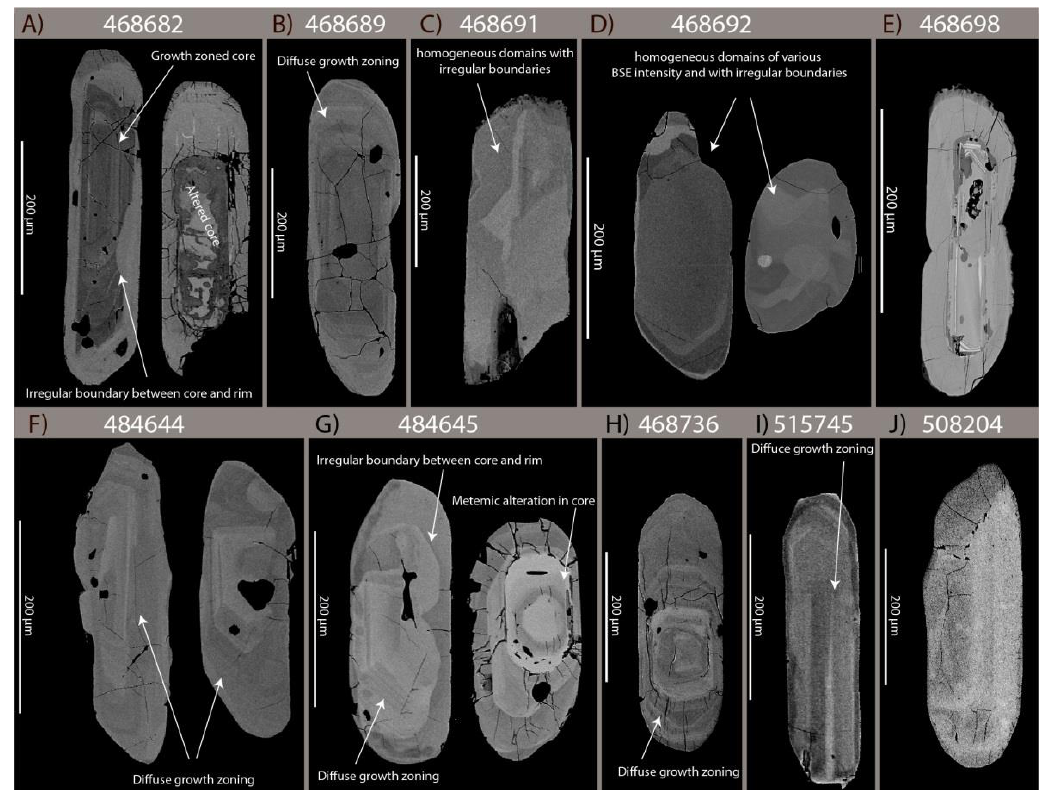
Figure 6. Zircon BSE images of selected representative grains. ( A ) Grains with core-rim domains. The core in the left grain is growth zoned whereas the right grain has a strongly altered core. The rim in both grains is BSE bright and homogeneous. ( B ) Zircon grain dominated by diffuse growth zoning. ( C , D ) Grains with irregular homogeneous domains. ( E ) Grain with an altered core, the alteration is focused into a zone separating the core from the rim, very bright zones are ZrO 2 (baddeleyite). ( F ) Grains mainly with diffuse growth zoning but the upper part of right grain also displays homogeneous domains with irregular boundaries. ( G ) Grain with core-rim domains. The left grain displays a diffuse boundary between core and rim. The right grains are divided into core and two rim domains with different BSE intensity, the inner core is strongly altered. ( H , I ) Diffuse growth zoning. ( J ) Homogeneous rim like domain is observed in the right site of the domain that also displays a wavy grain edge, diffuse zoning dominates the right part of the